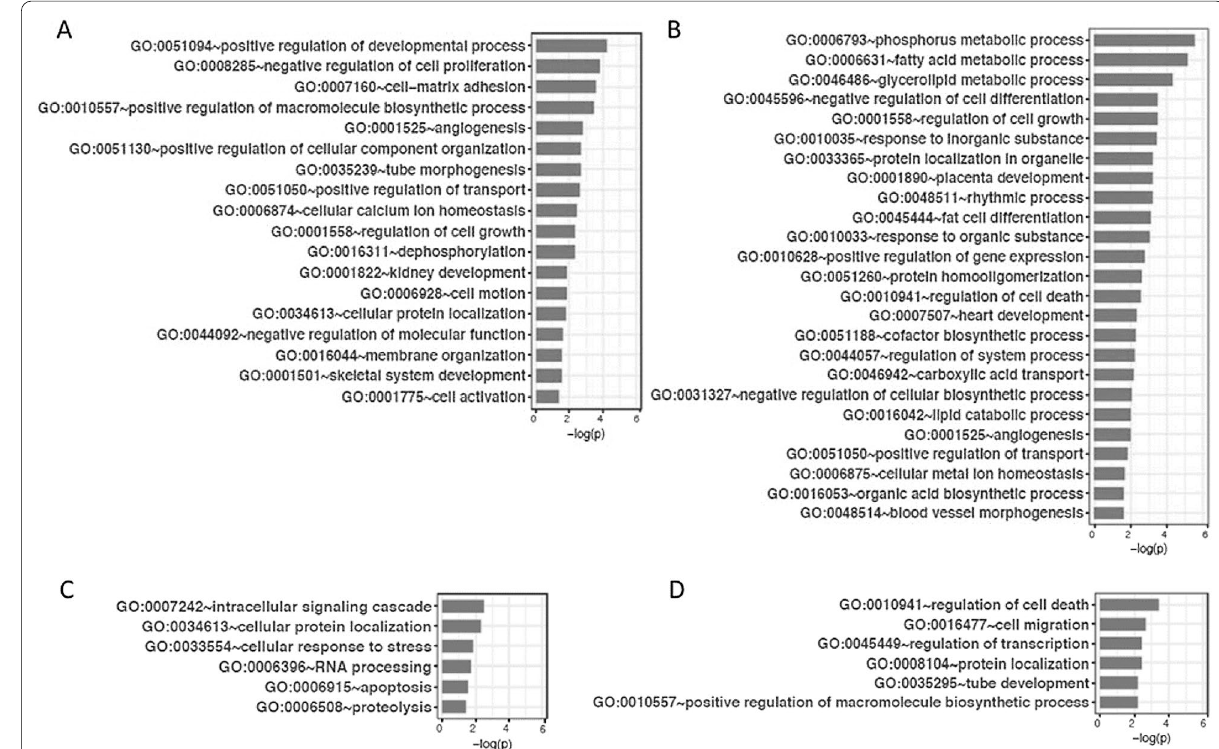
Fig. 2 Renal functions that are regulated in a circadian fashion in NZB/W kidneys. A Young mice ZT0; B Young mice ZT12; C Nephritic mice ZT0; D Nephritic mice